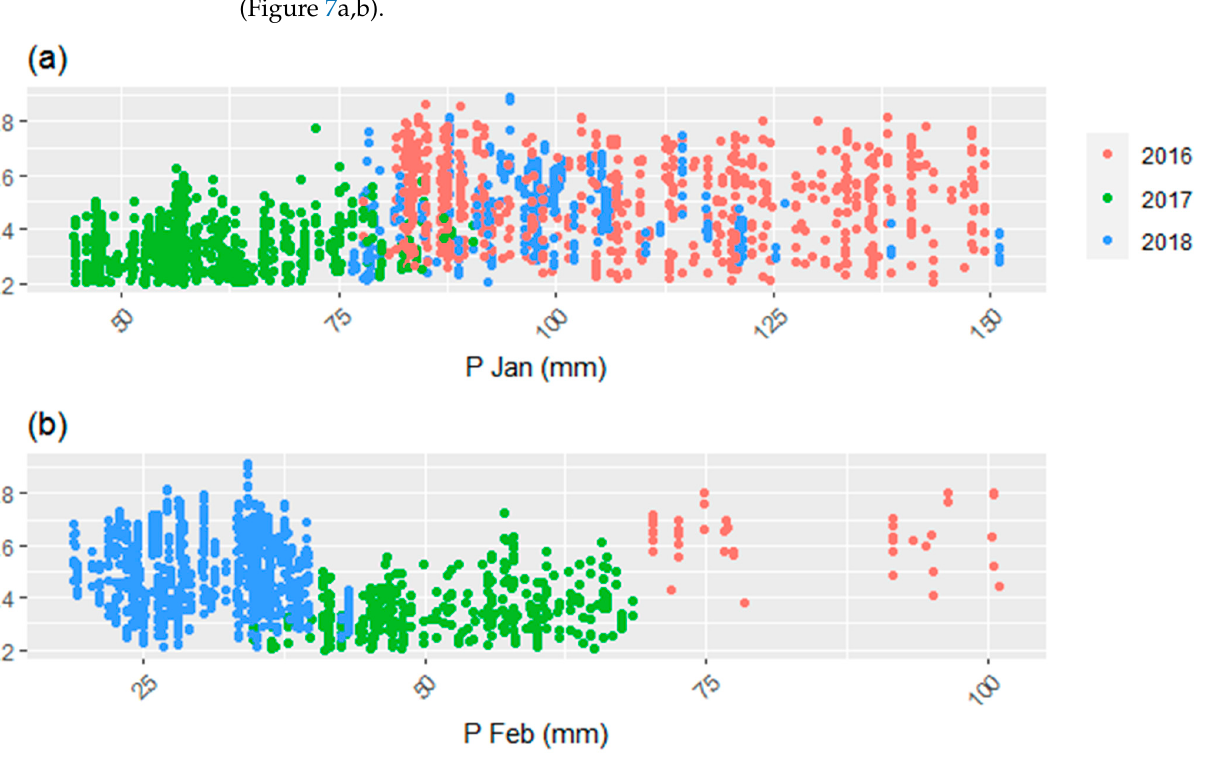
Figure 8. ( a ) Scatterplot of NDVI observation and precipitation for the month of January; ( b ) scatterplot of NDVI observa- tion and precipitation for the month of February; ( c ) scatterplot of NDVI observation and precipitation for the month of June. 4. Discussion The model performance metrics of the yield model using aNDVI as a predictor vari- able for winter wheat yield modelling in northern Belgium indicated that the integral NDVI during the growing season (aNDVI) was not a good predictor of winter wheat yield (Table 1, Model 1), which is in contrast to a study in Latvia [4]. The variance explained for